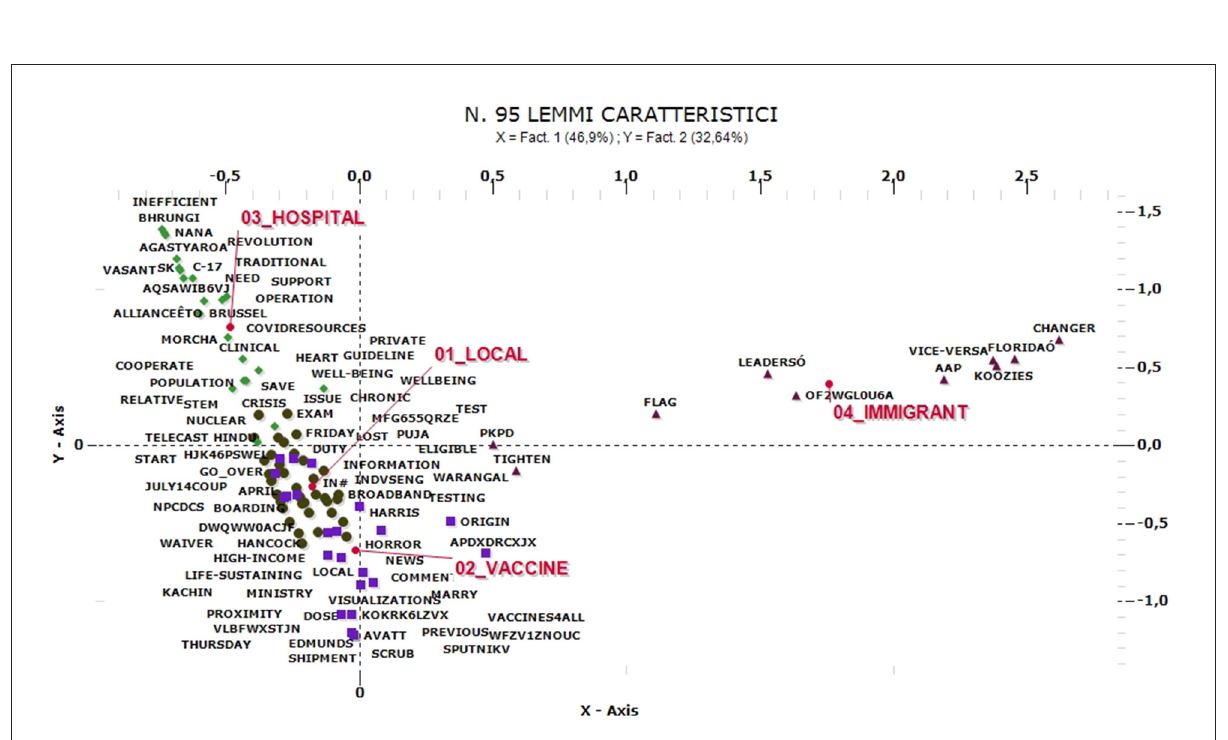
FIGURE11 ACM—“COVID-19” comments in English (95 characteristic